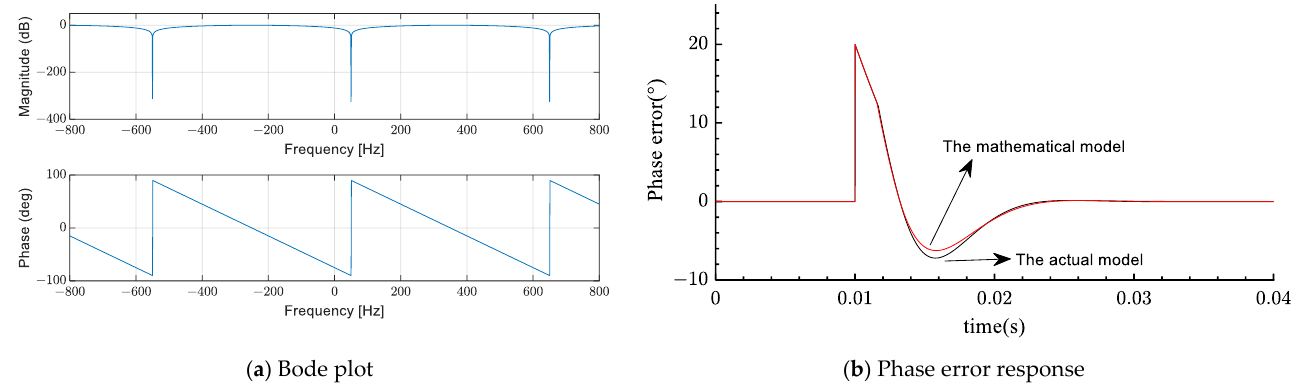
Figure 6. ( a ) Bode plot of the MDSC operator with n = 12. ( b ) Accuracy assessment of the mathemat- ical model of the proposed PLL with n = 12.